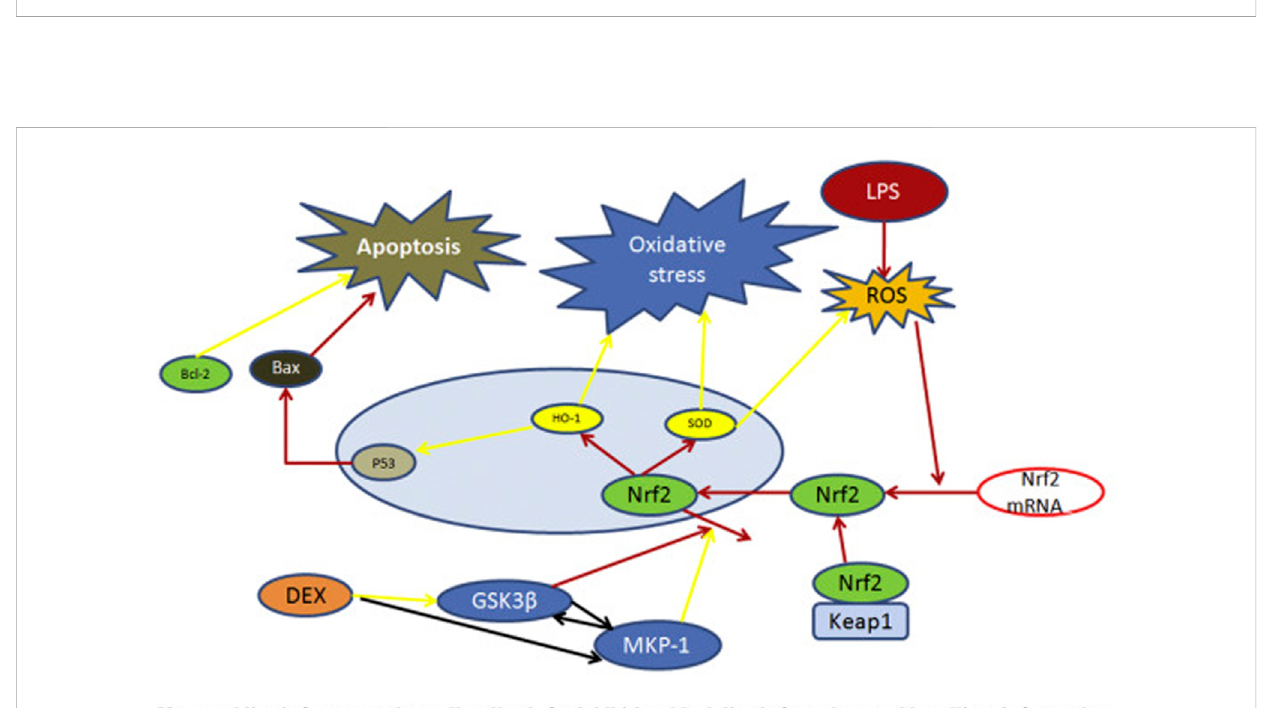
FIGURE 9 Aschematic representationofDexmedetomidine'sprotective effectsontheliver.Dexmedetomidineattenuateslipopolysaccharidesinvolvedinthe inhibition or downregulation of the activity of reactive